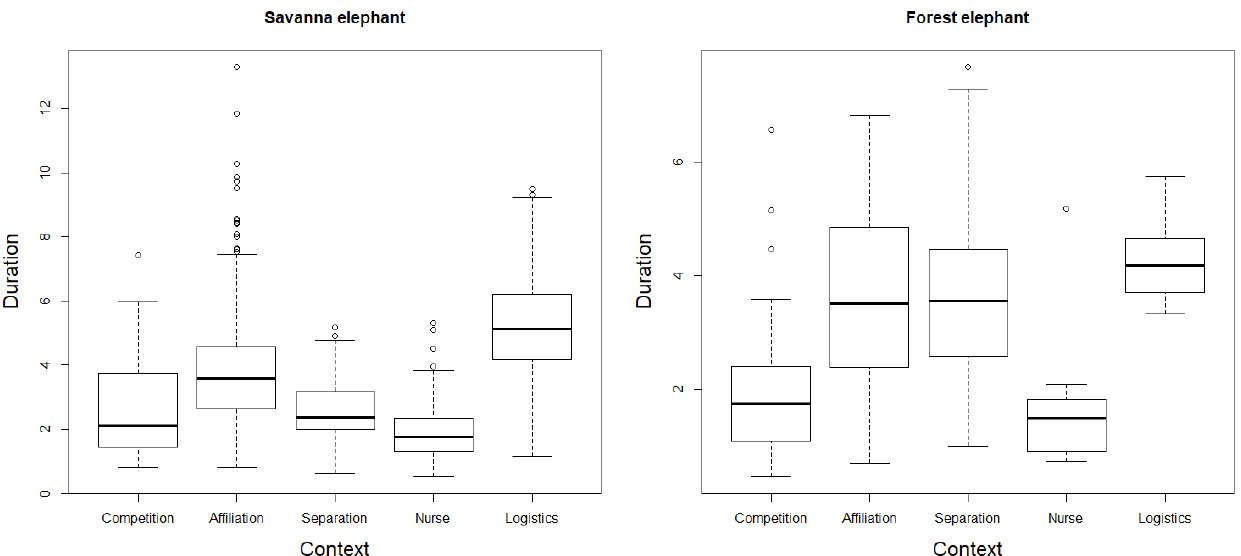
Figure 2. Relationship between context and the duration of rumbles produced by forest elephants (N = 246 calls) and savanna elephants (N = 1177). Statistical analysis for forest elephants excluded the contexts of sexual and anti-predatory, as well as adult males and infants due to the small sample size (see Table 1). These were included in the analysis for savanna elephants, but the two contexts were omitted in the figure for comparability. See Tables S3 and S4 in Supplementary Material for detailed results of the linear regression investigating how the duration of rumbles differed between contexts in the two species.